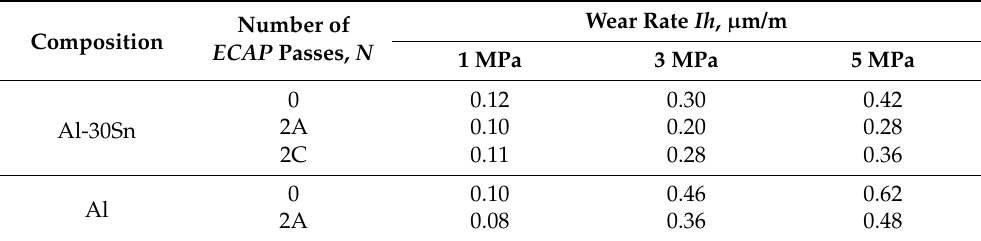
Table 1. Effect of pressure ( P ) and number of ECAP passes ( N ) with routes A and C on the wear rate ( Ih ) of the Al-30Sn alloy and sintered pure aluminum under dry friction against steel. V = 0.6 m/s, L = 500 m. Number of Composition ECAP Passes,